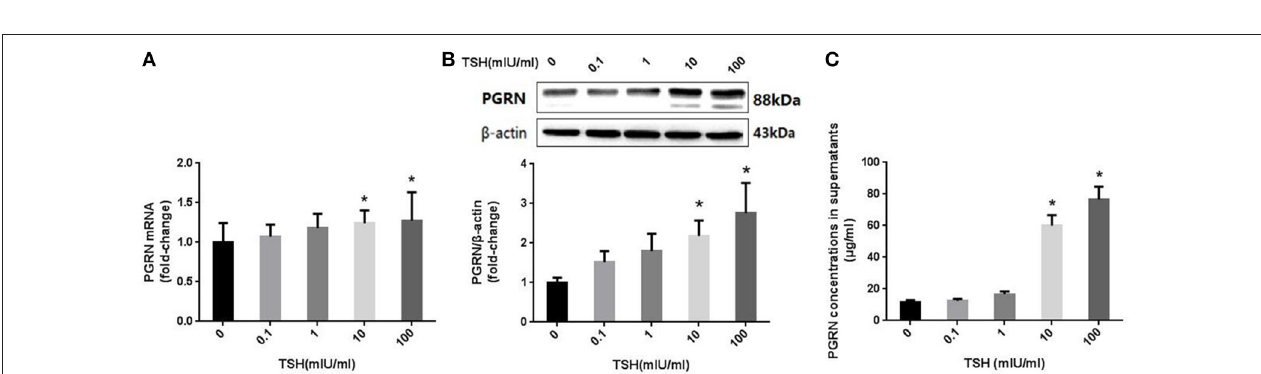
FIGURE 6 | Effect of TSH on PGRN in HUVECs. HUVECs were stimulated by different concentrations of TSH (0, 0.1, 1, 10, and 100 mIU/mL) for 24h. (A) mRNA level of PGRN in HUVECs stimulated by different concentrations of TSH as assessed by real-time PCR; (B) Protein expression of PGRN in HUVECs treated with different concentrations of TSH as assessed by Western blot; this actin from figure 3 was re-used here, because PGRN was detected at the same time with eNOS in one experiment of WB; (C) PGRN concentrations in supernatant from HUVECs stimulated by different concentrations of TSH. Data were obtained from three separate experiments. HUVECs without stimulating with TSH (0 mIU/mL) served as control; * P < 0.05, when compared with the control.